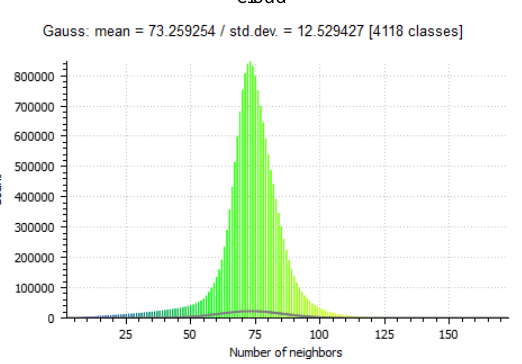
Figure 14. Density analysis histogram of the photogrammetric point